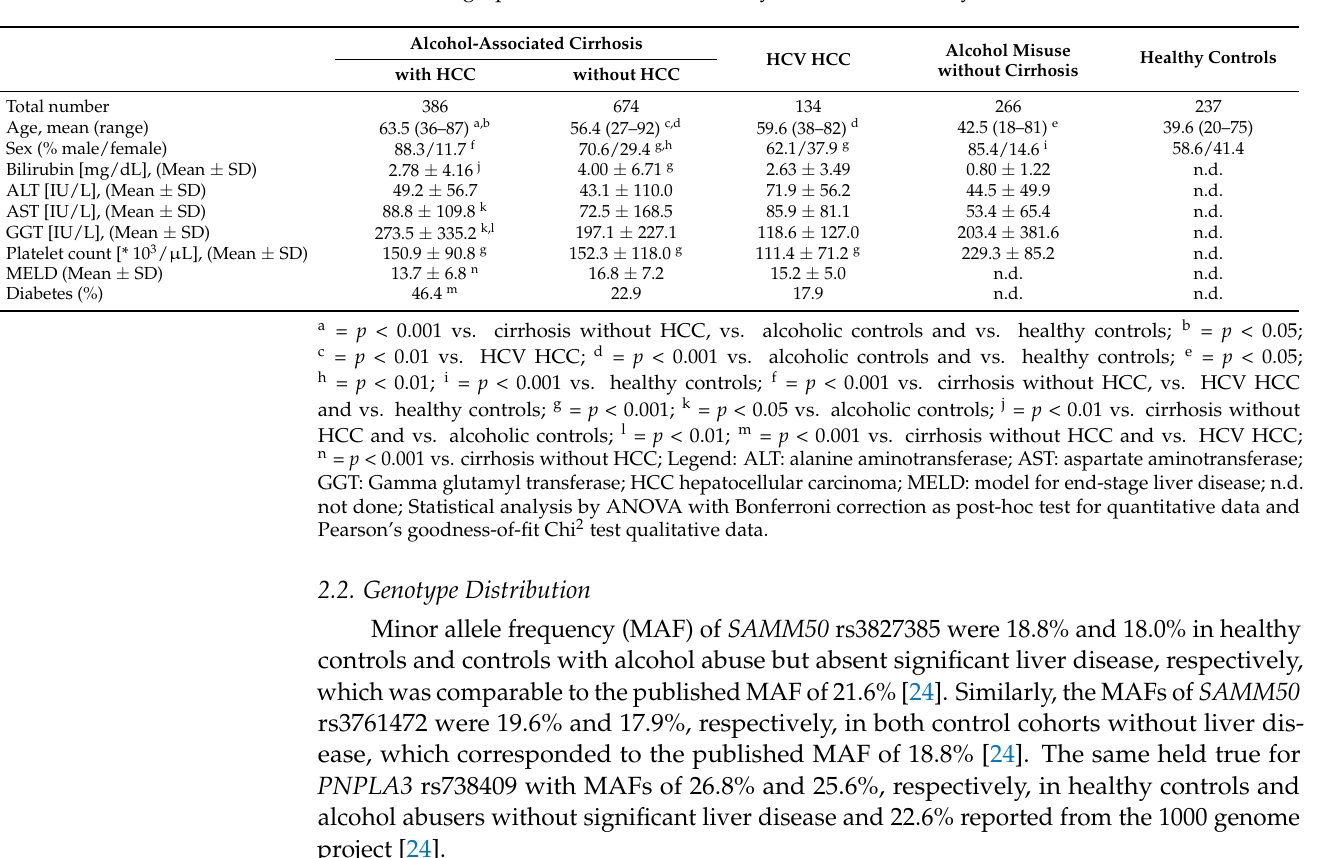
Table 1. Demographic, clinical and laboratory details on the study